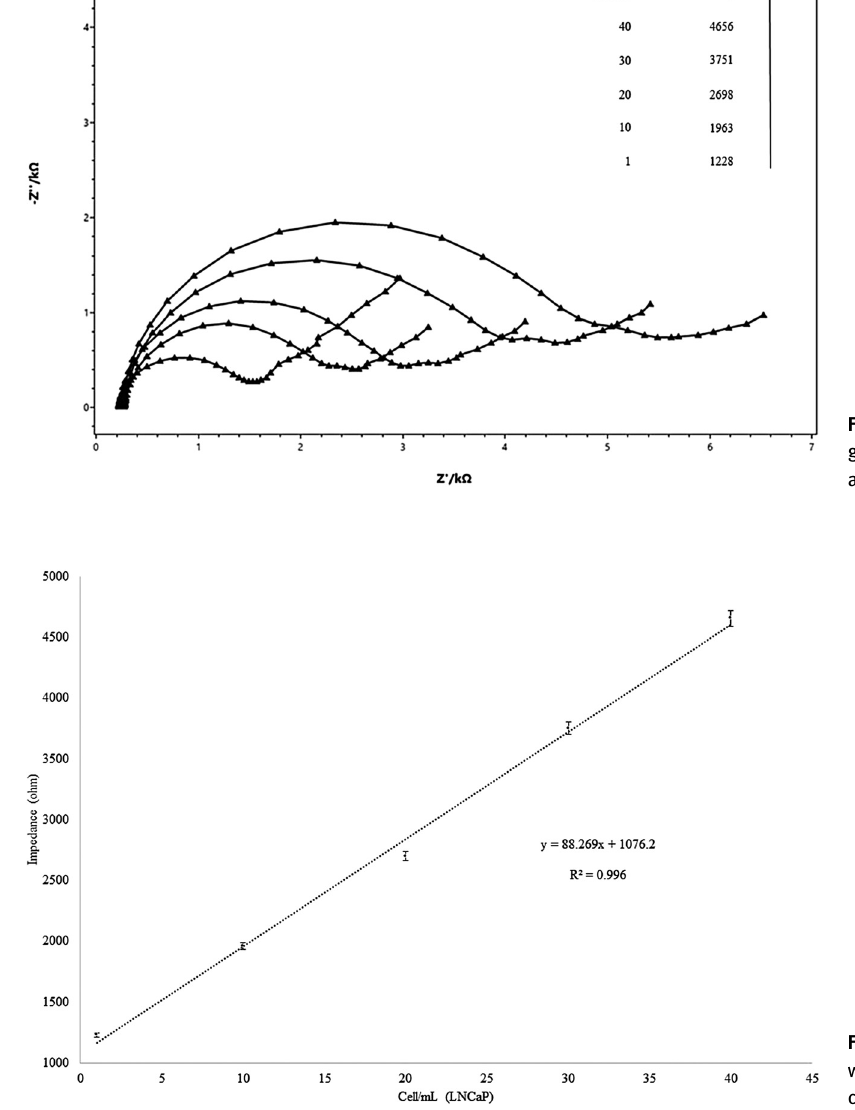
Figure5: CalibrationcurveofLNCaPbiosensor where y is impedance and x is cell/mL concentration ( y = 88.269 +